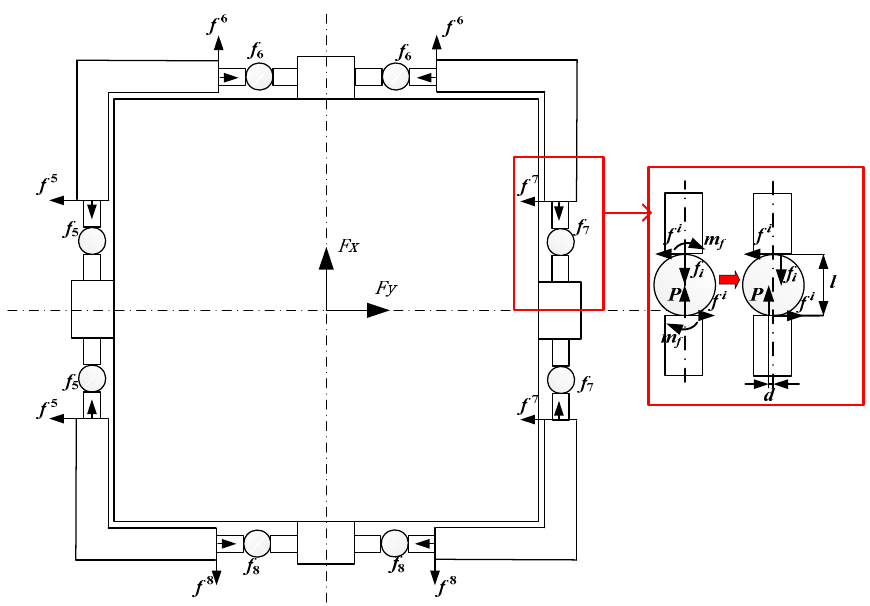
Figure 5. Force diagram of the proposed sensor in the X - Y plane.